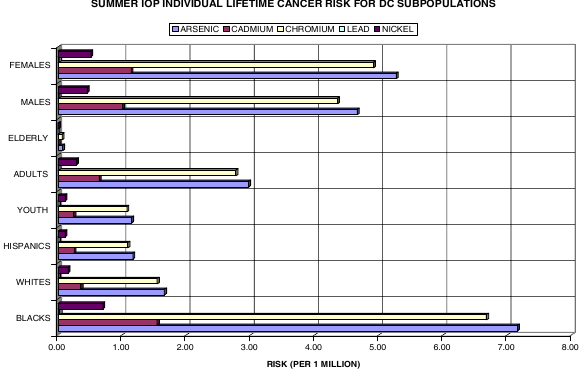
Figure 11: Fall IOP Lifetime Excess Lung Cancer Risk by DC Ward